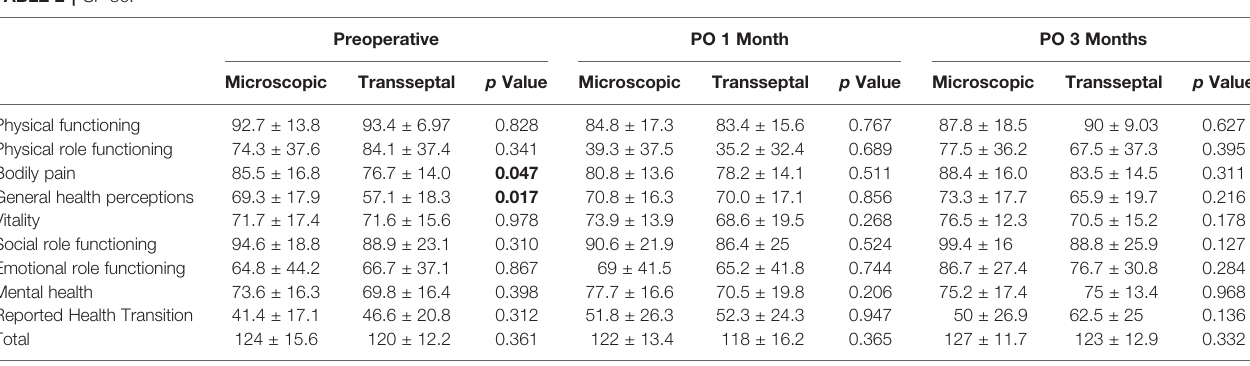
Values represent mean± standard deviation. Bold values: statistically signi fi